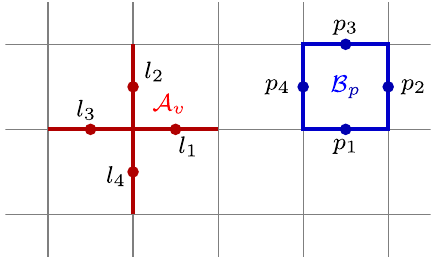
FIG. 1. Representation of a star operator A v (in red) and a pla- quette operator B p (in blue), with the corresponding qubits on the links (solid